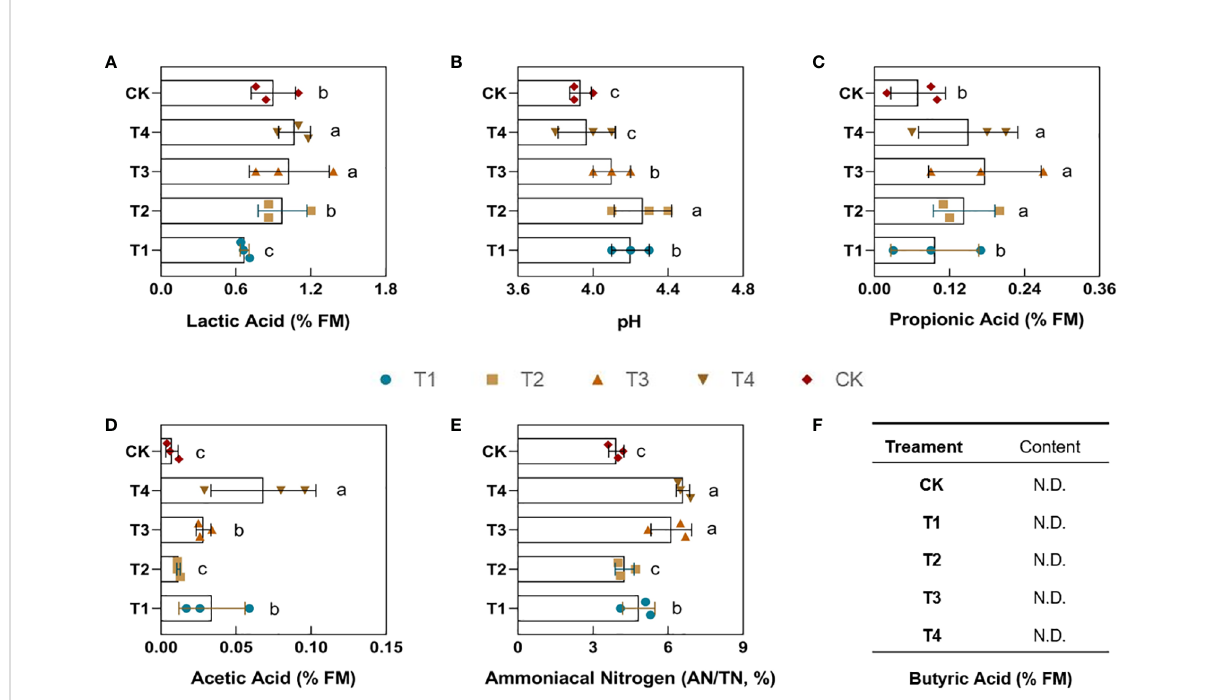
FIGURE 4 Effect of different periods of drought treatment on the fermentation quality of maize silage. The fi gure includes lactic acid (A) , pH (B) , propionic acid (C) , acetic acid (D) , ammoniacal nitrogen (E) , and butyric acid (F) . T1, seedling stage; T2, elongation stage; T3, fl owering stage; T4, maturity stage. Different letters above the bars indicate that the values differ signi fi cantly